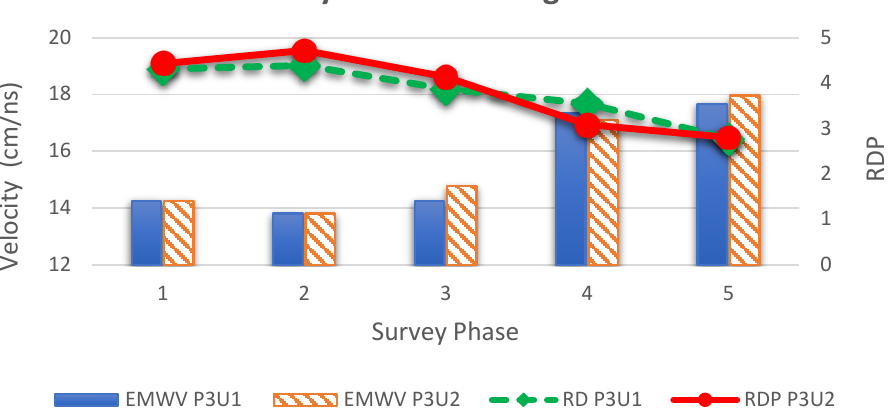
Figure 9. The change of Electromagnetic Wave Velocity (EMWV) and RDP values during the lifecycle of the railway track in section P2.